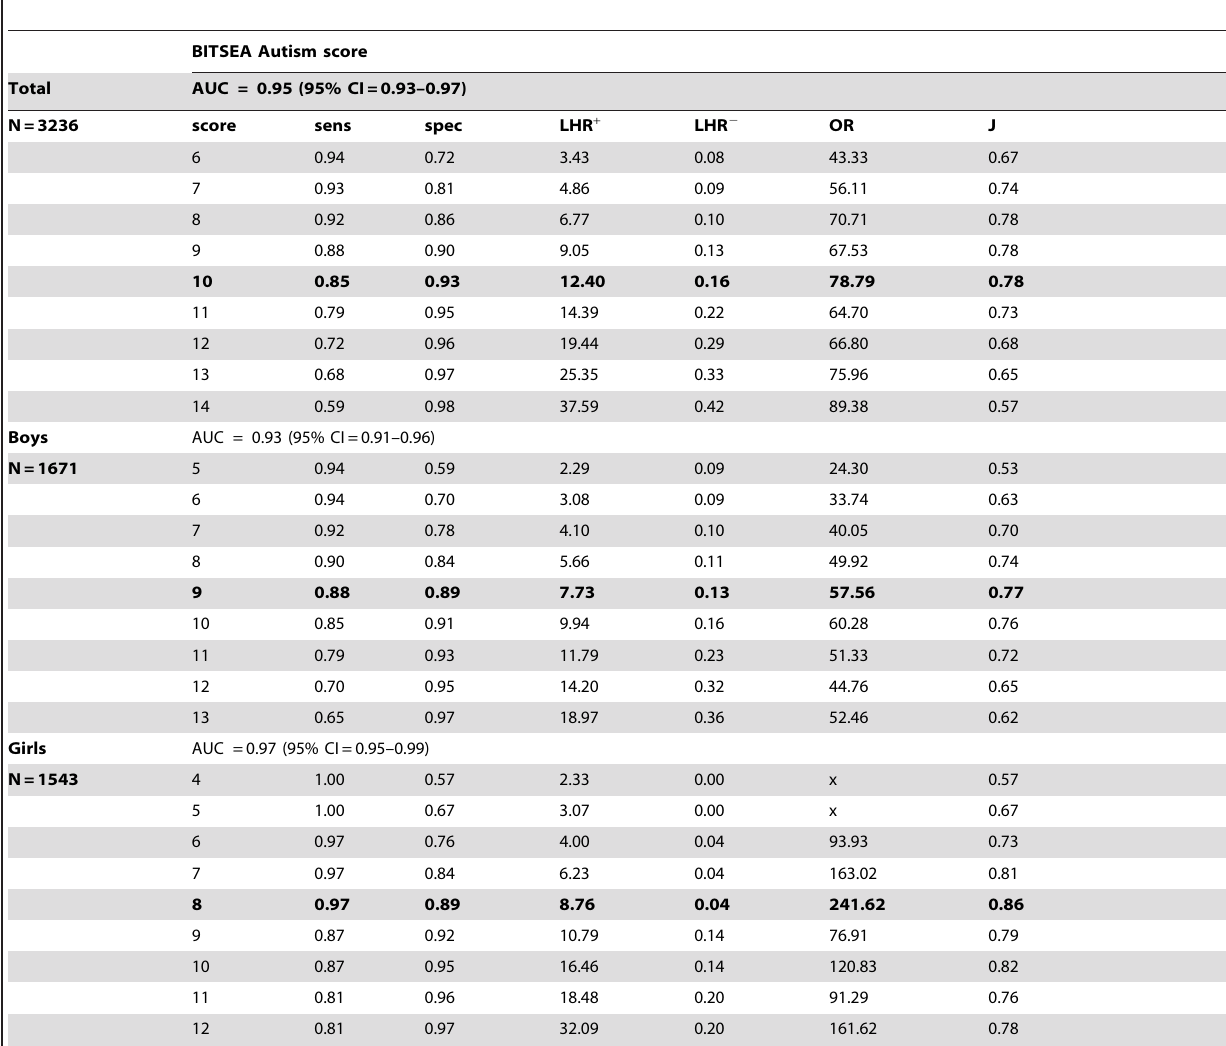
Table 3. The screening accuracy of the BITSEA Autism score: Area Under the Curve and sensitivity, specificity, liklihood ratio’s, diagnostic odds ratio and Youden’s index for a range of Autism scores, for the total sample and for subgroups by